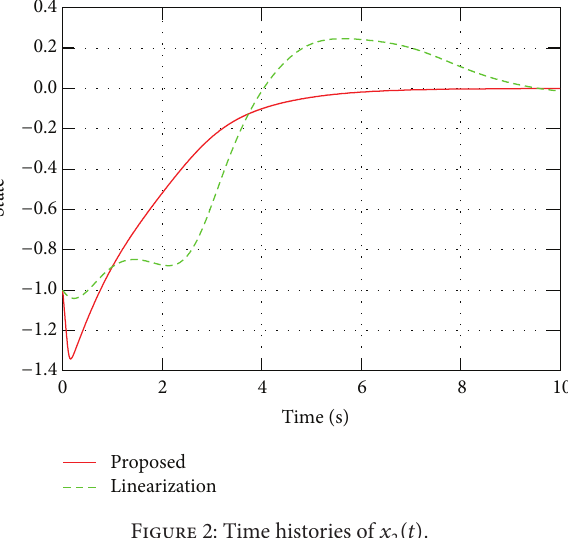
Figure 1: Time histories of 𝑥 1 (𝑡) . Figure 2: Time histories of 𝑥 2 (𝑡) .